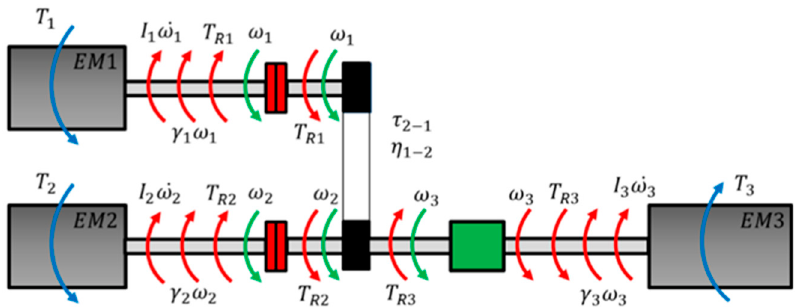
Figure 4. Torques acting on the real test bench for the hybrid propulsion architecture under analysis during power boost.